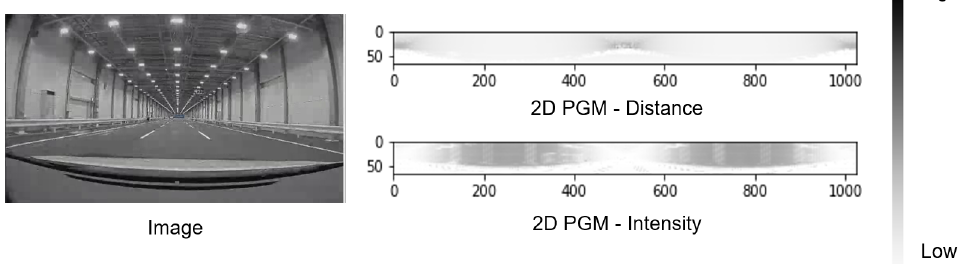
Figure 3. Examples of the JARI driving laboratory and 2D PGM. The left figure shows an example image of the JARI environment where the data are collected. The right ones show the Polar-Grid map (i.e., 2D PGM), which represents the LiDAR 3D point cloud as a 2D grid. The top figure of right ones is an example of 2D PGM for distance and the figure below those is that of 2D PGM for intensity in the JARI environment. Black is higher value and white is lower value in the 2D PGM